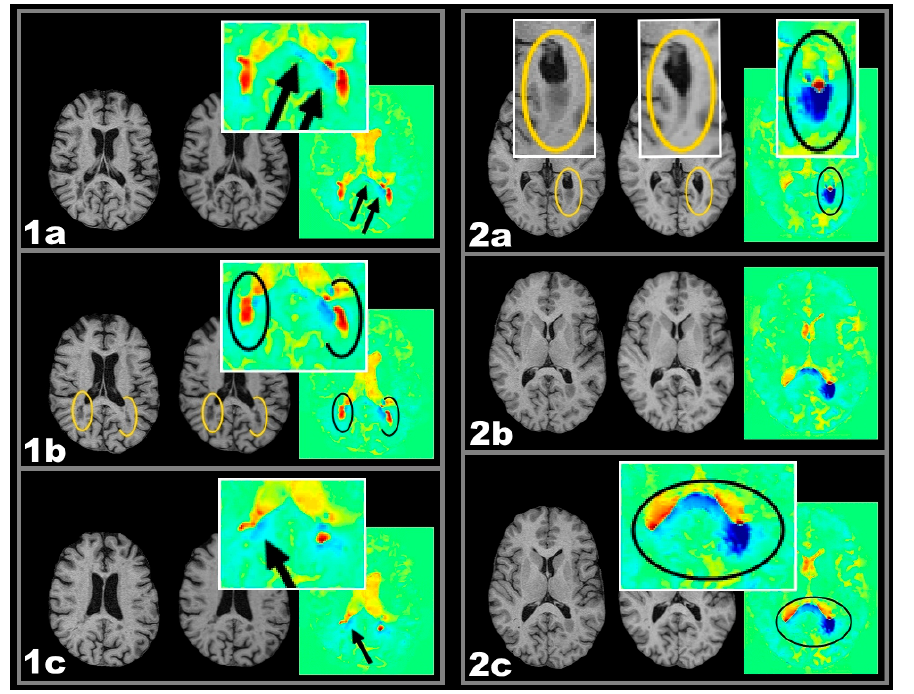
Figure 2. One year follow-up T1w MRI and respective colour coded VGM maps demonstrating different types of volume change. Important detail is highlighted in elipses. Two exemplary cases with active lesions and spatially related callosal volume decrease: Case 1 CEL, Case 2 CSL. From left to